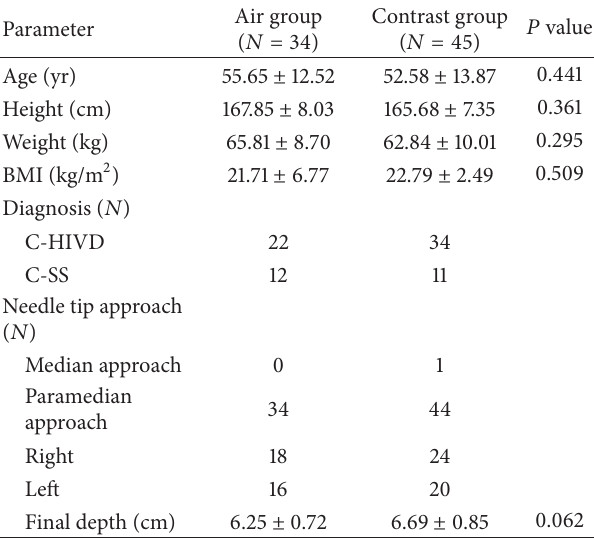
Table 1: Study patient characteristics and the final depth of the cervical epidural space.